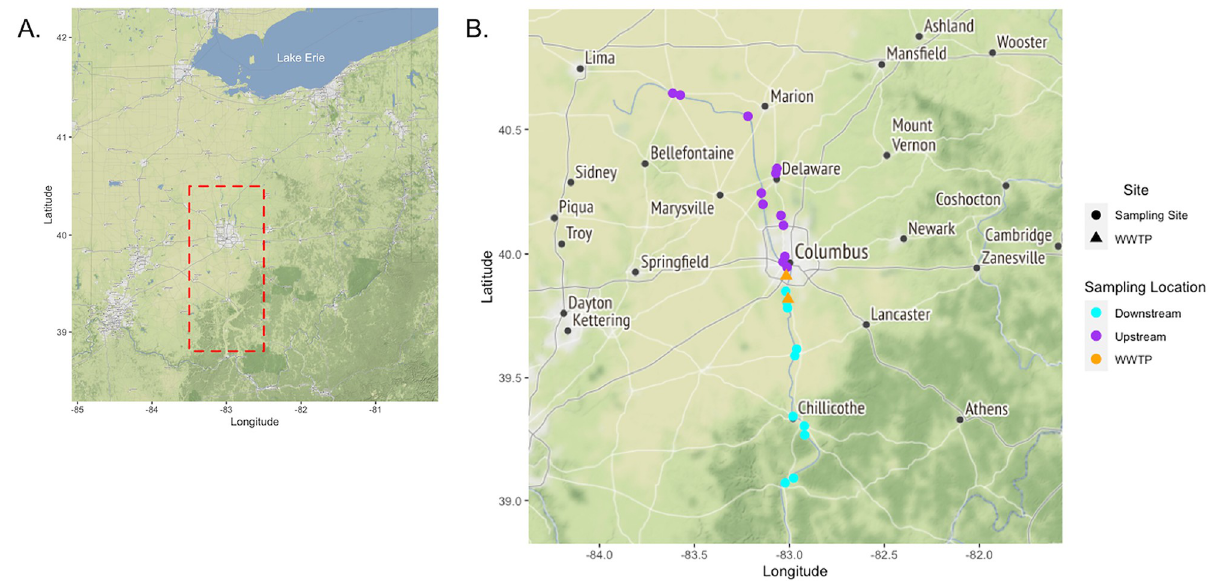
Fig 1. Distribution of fish sampling sites and WWTP along the Scioto River Watershed in Central Ohio. A) Map of the Ohio region. Red dash box indicates a zoomed-region of the study sample area exemplified in B. B) The study area centered in Scioto Darby Watershed in Central Ohio. Sampling sites are colored circles based on their distribution upstream or downstream of WWTP. WWTP are represented as orange triangles.